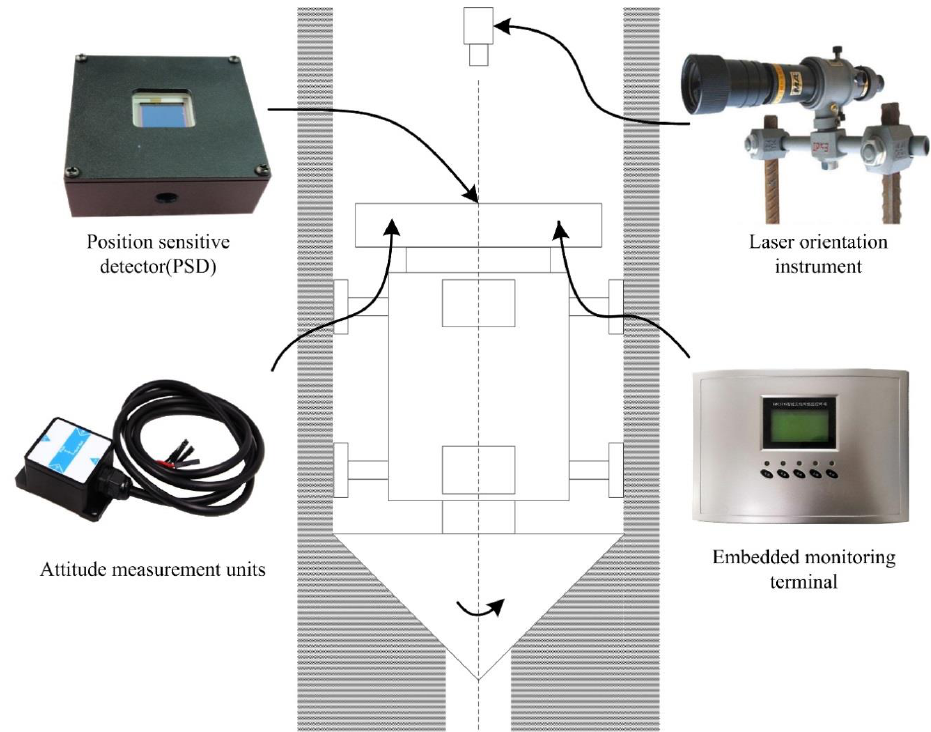
Figure 3. Hardware composition of the attitude measurement system. Figure 4. Composition of the attitude measurement unit.